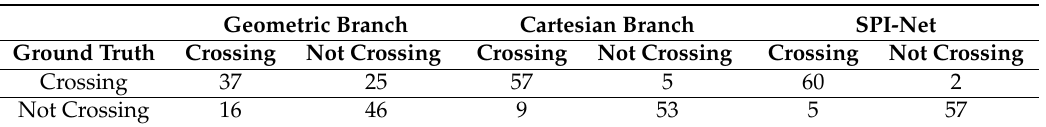
Table 4. Confusion matrix of the JAAD data set obtained by each branch of SPI-Net and SPI-Net on JAAD for the C/NC